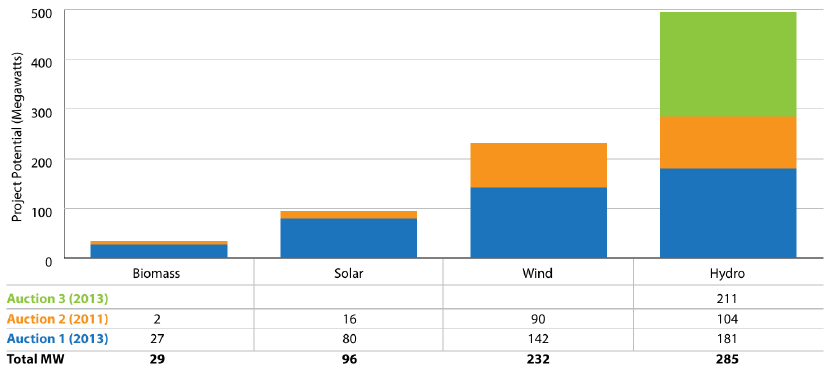
Figure 13. Renewable energies auction in Peru